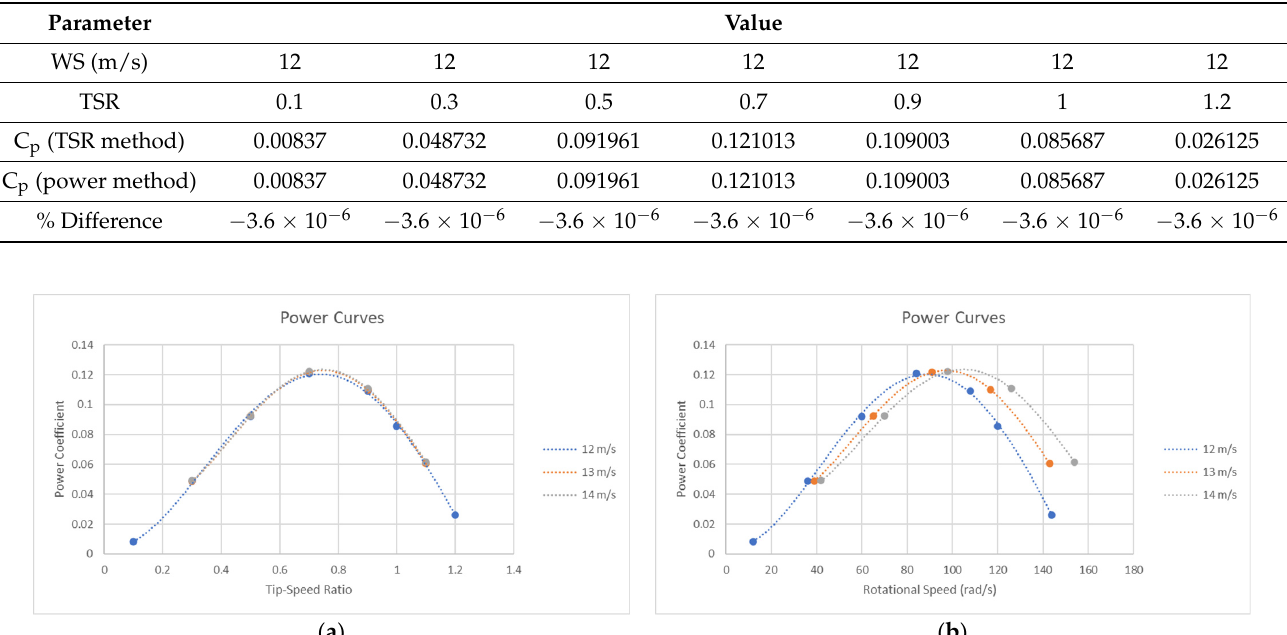
Table 5. Coefficient of performance calculation method comparison.